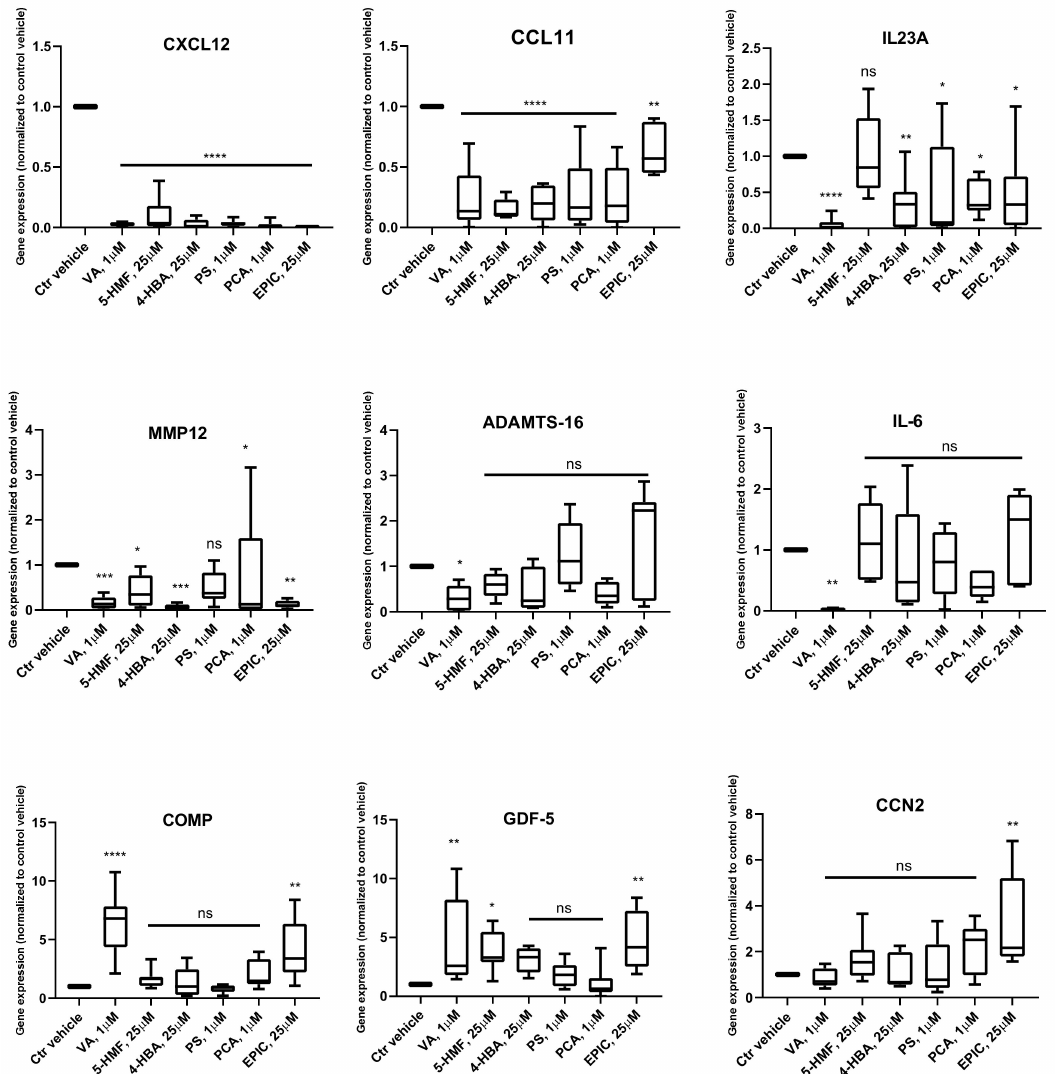
Figure 1. qPCR data showing transcriptional levels of genes di ff erentially expressed in RNA sequencing dataset in compound treated versus control vehicle (Ctr vehicle) group in human osteoarthritis (OA) chondrocytes. n = 4; n indicates the number of human OA donors; for each donor, three experimental replicates were analyzed. Data are normalized to the levels of control groups. For statistical analysis using Graphpad Prism, one-way analysis of variance (ANOVA) followed by Dunnett’s post hoc test (multiple comparisons) was applied. * p < 0.01, ** p < 0.001, *** p < 0.0005, **** p < 0.0001 vs. Ctr vehicle, ns